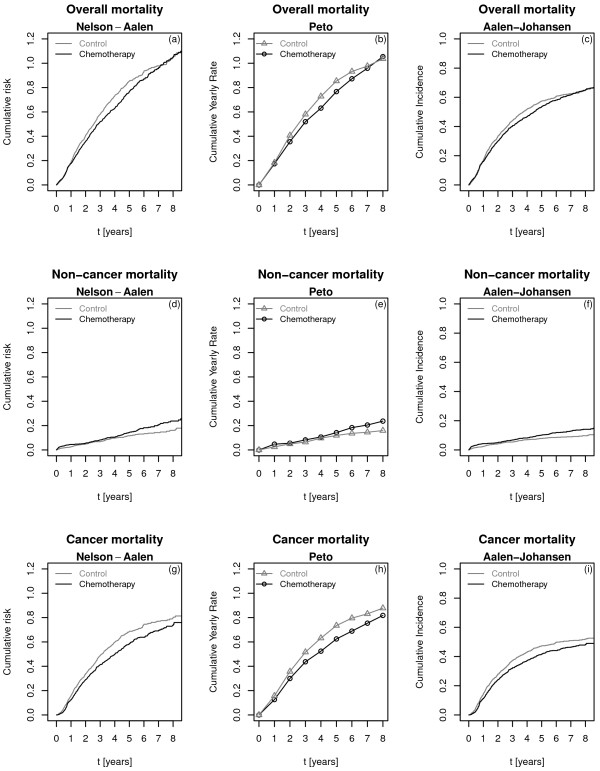
Overall and cause-specific mortality for control and treatment arms in the IALT trial.  First column ((a), (d), (g)): Nelson – Aalen estimates of the cumulative hazards. Second column ((b), (e), (h)): Peto estimates of the cumulative yearly rates. Third column ((c), (f), (i)): Aalen - Johansen estimates of the cumulative incidence functions. First line ((a) – (c)): overall mortality. Second line ((d) – (f)): non-cancer mortality. Third line ((g) – (i)): cancer mortality.